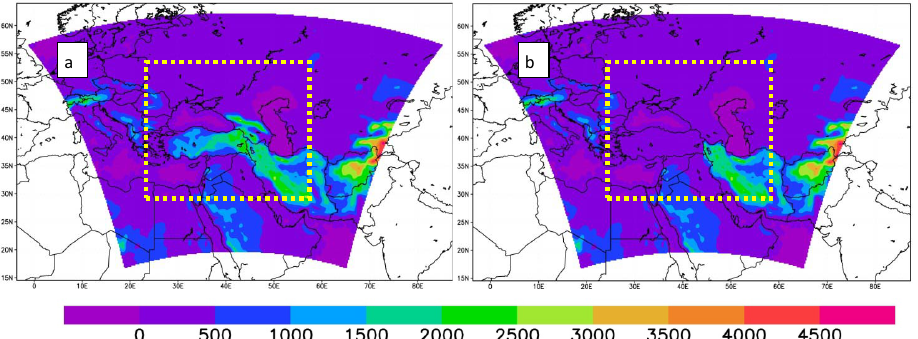
Fig. 1.Model topography for the inner domain in (a) CTL and (b)EXP. Fig. 1. Model topography for the inner domain in (a) CTL and (b) EXP.